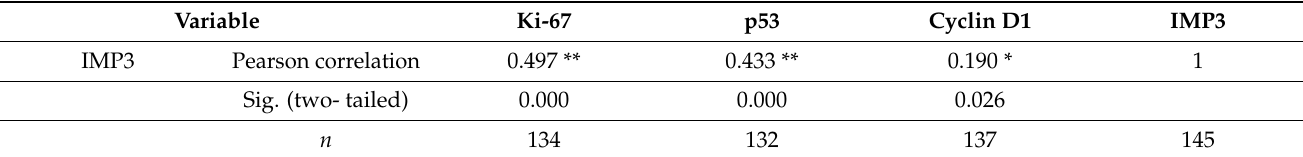
Comparing the clinical and pathological features of LSCC (Table 4), we found an overexpression of IMP3 and Ki-67 in those tumors that metastasized to regional neck